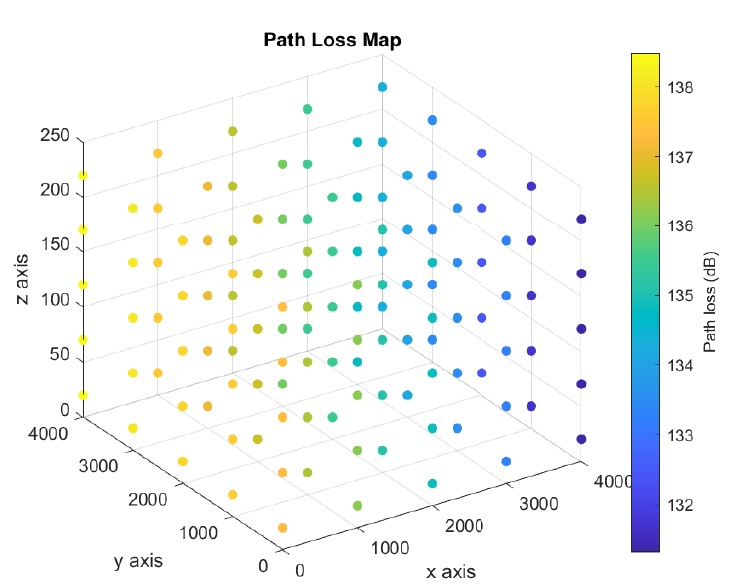
Figure 4. Dense path loss map.